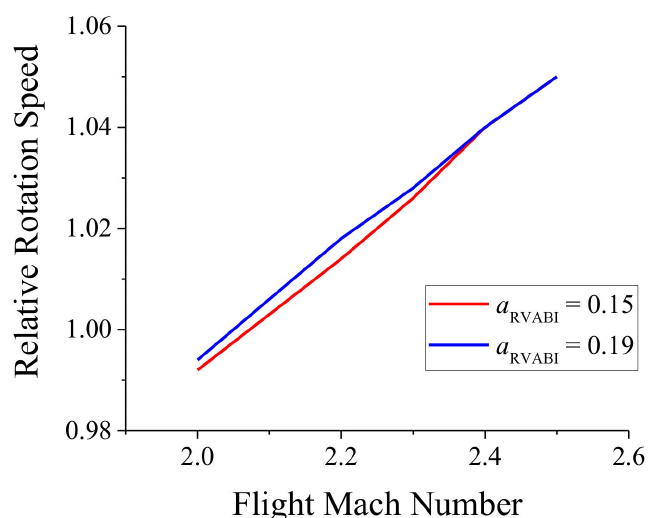
Figure 29. The Variations of Relative Rotation Speed of High-Pressure Shaft at the conditions of Different Area Coefficients of RVABI ( α RVABI